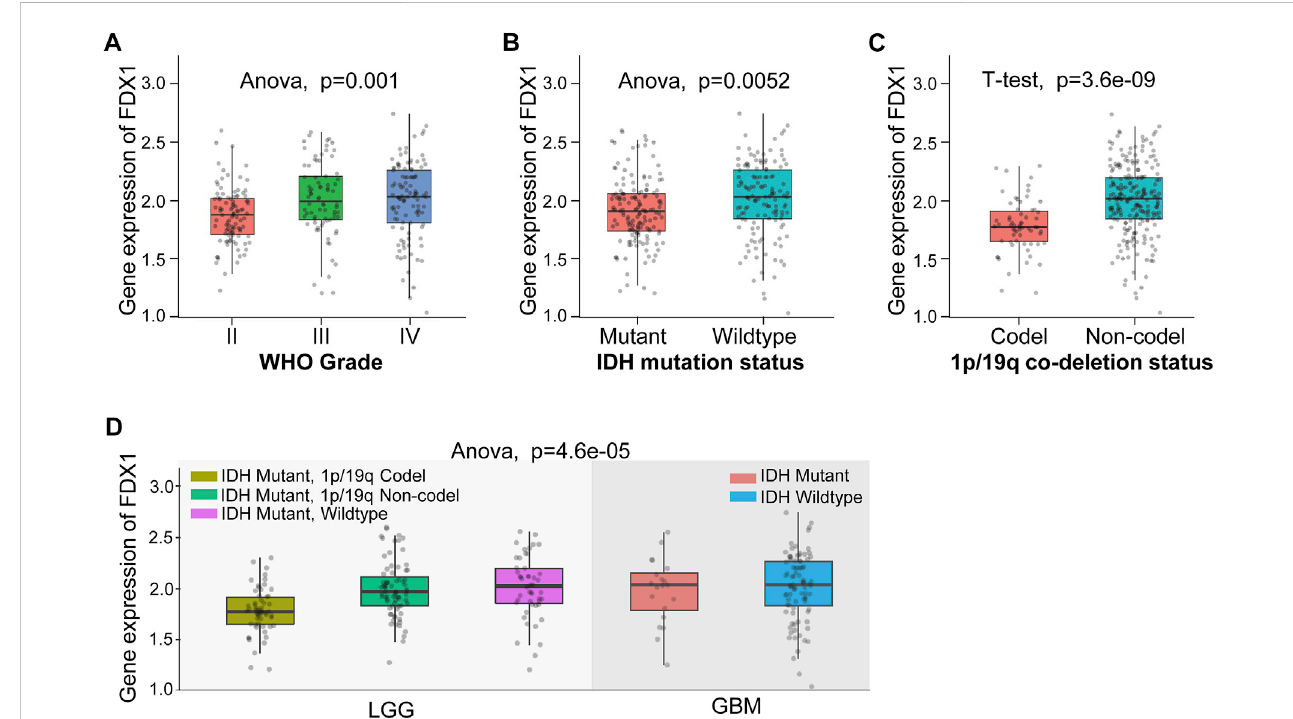
FIGURE 7 The differential expression of FDX1 in brain lower-grade glioma (LGG) according to Chinese Glioma Genome Atlas (CGGA) database. (A) Differential expression of FDX1 in different grades in LGG. (B) Differential expression of FDX1 in LGG depended on isocitrate dehydrogenase (IDH) mutation status. (C) Differential expression of FDX1 in LGG depended on 1p/19q co-deletion status. (D) Differential expression of FDX1 in LGG depended on IDH mutation status combined with 1p/19q co-deletion status. (All statistical methods were shown in the fi gure, p < 0.05 was considered signi fi cant.)